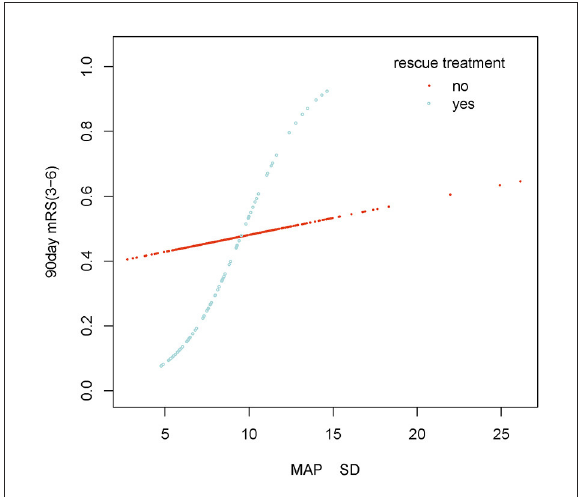
FIGURE7 Smooth curve fitting of MAP SD and futile recanalization in rescue treatment subgroup. Adjustment variables: Male, Age, Hypertension, Diabetes mellitus, Atrial fibrillation, Level of occlusion on DSA imaging, ASPECTS, Baseline NIHSS, Puncture to recanalization, Onset to recanalization, rescue treatment, Continuous intravenous antihypertensive agents, Bridging treatment, MAP